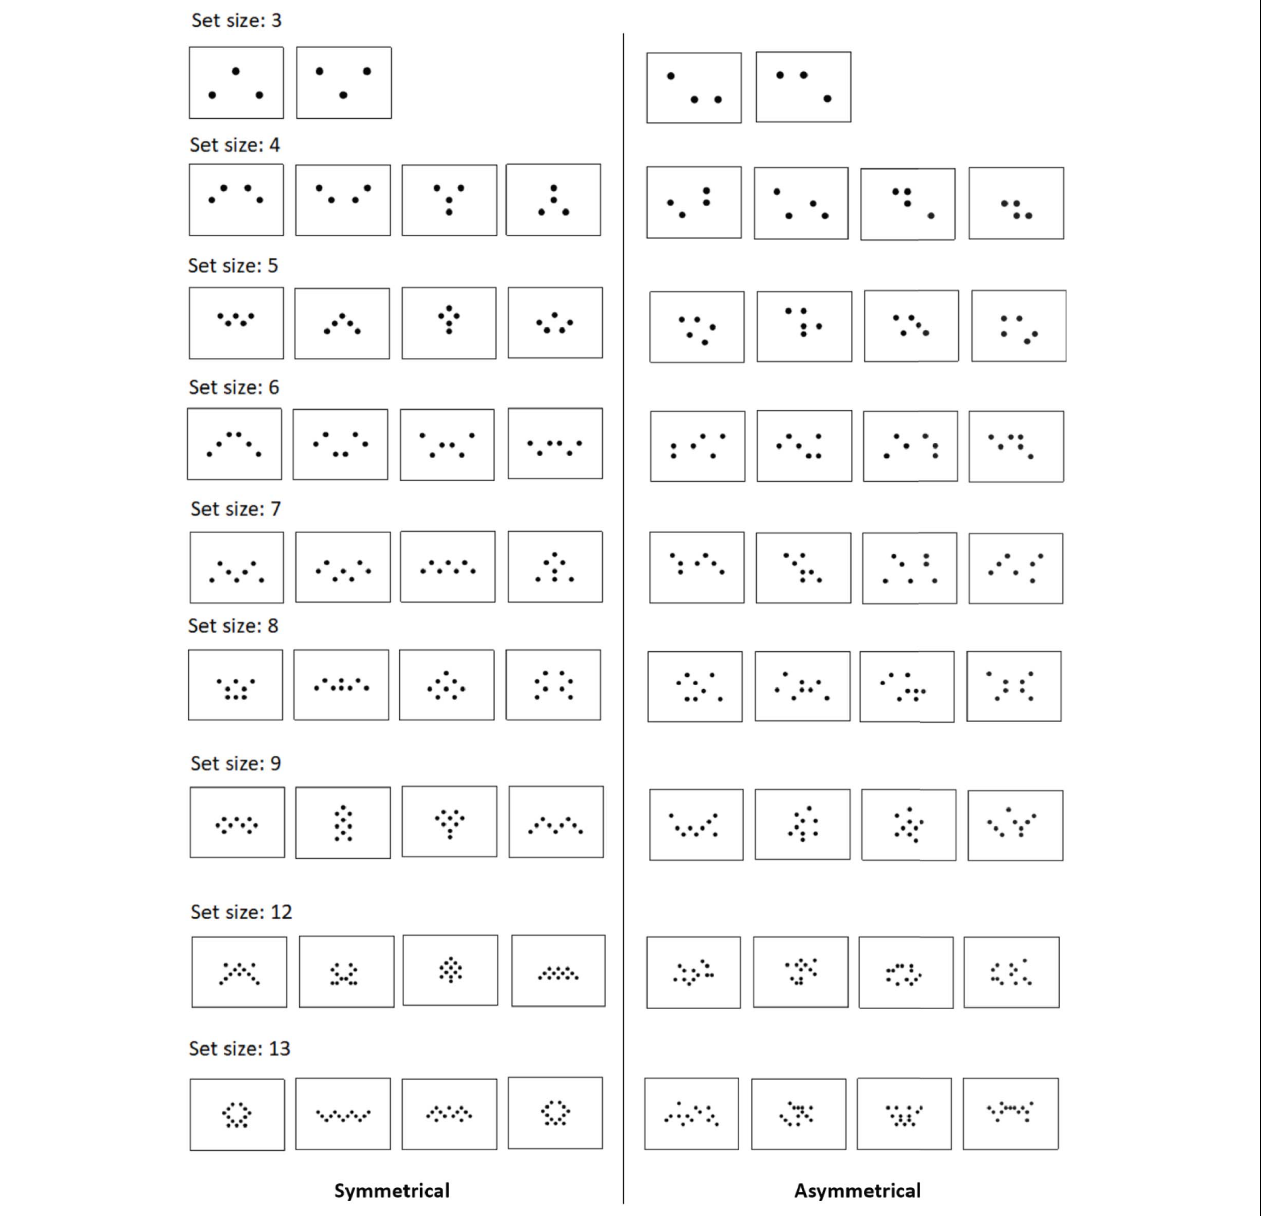
FIGURE 1 | Symmetrical and asymmetrical designs from this study. A number of dots are balanced between left and right sides. Asymmetric versions are created by randomly moving 50% of the dots from their symmetrical counterparts. Odd-numbered set sizes were scaled down by 1 disc. In addition, the black-to-white ratio was kept the same across all set sizes such that the number of black pixels is always the same in every trial throughout the entire experiment regardless of set